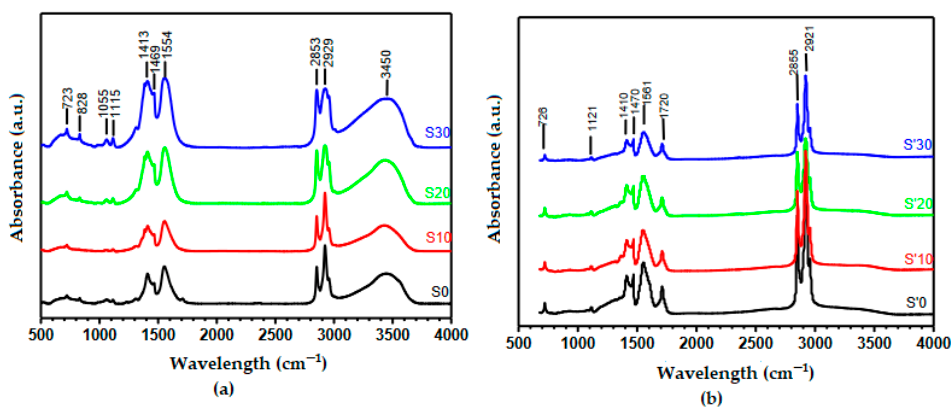
Figure 2. Fourier transform infrared (FTIR) spectra of samples ( a ) S0, S10, S20, S30 and ( b ) S’0, S’10, S’20, S’30.